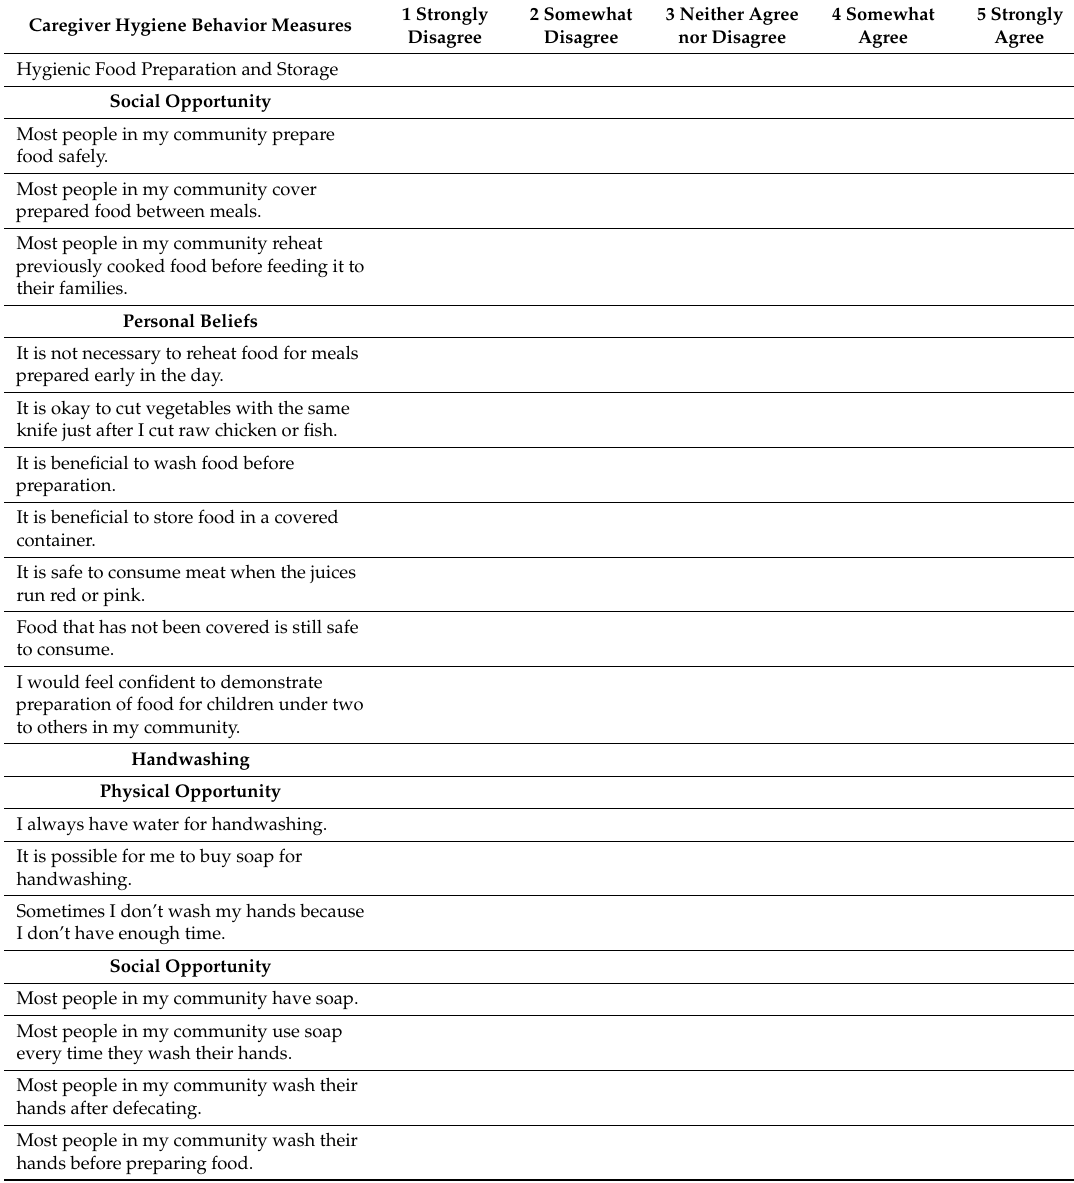
Table A1. Hygiene behaviors tool, organized by measure and